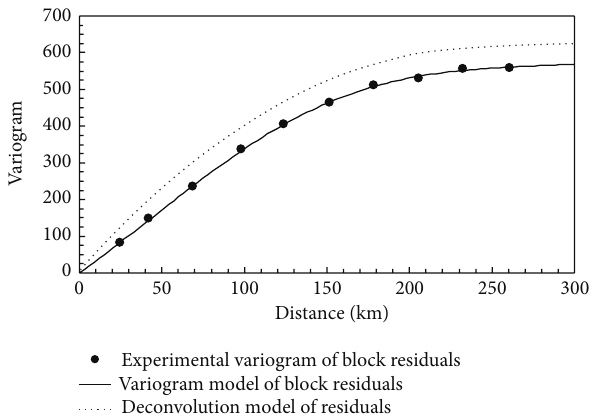
Figure 3: Variogram deconvolution results for residual compo-